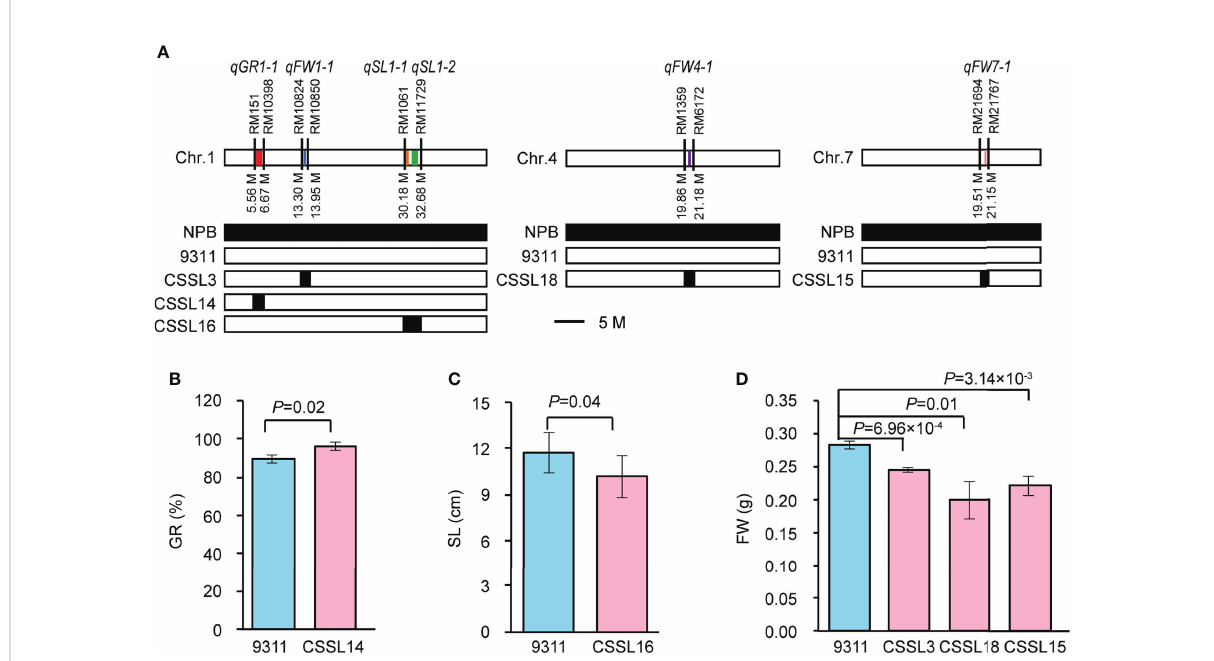
FIGURE 4 Validation of six GWAS-associated QTLs using CSSLs. (A) The genotype diagrams of CSSLs. qGR1-1 , qSL1-1 , qSL1-2 , qFW1-1 , qFW4-1 , qFW7-1 are represented by red, orange, green, blue, purple, and yellow lines, respectively. Line width indicates the size of QTL interval. (B) Comparison of GR between CSSL14 and 9311. Data represent mean ± SD (n=3). (C) Comparison of SL between CSSL16 and 9311. Data represent mean ± SD (n=10). (D) Comparison of FW among CSSL3, CSSL18, CSSL15, and 9311. Data represent mean ± SD (n=3). n indicates the number of replicates. The p-value is obtained from the